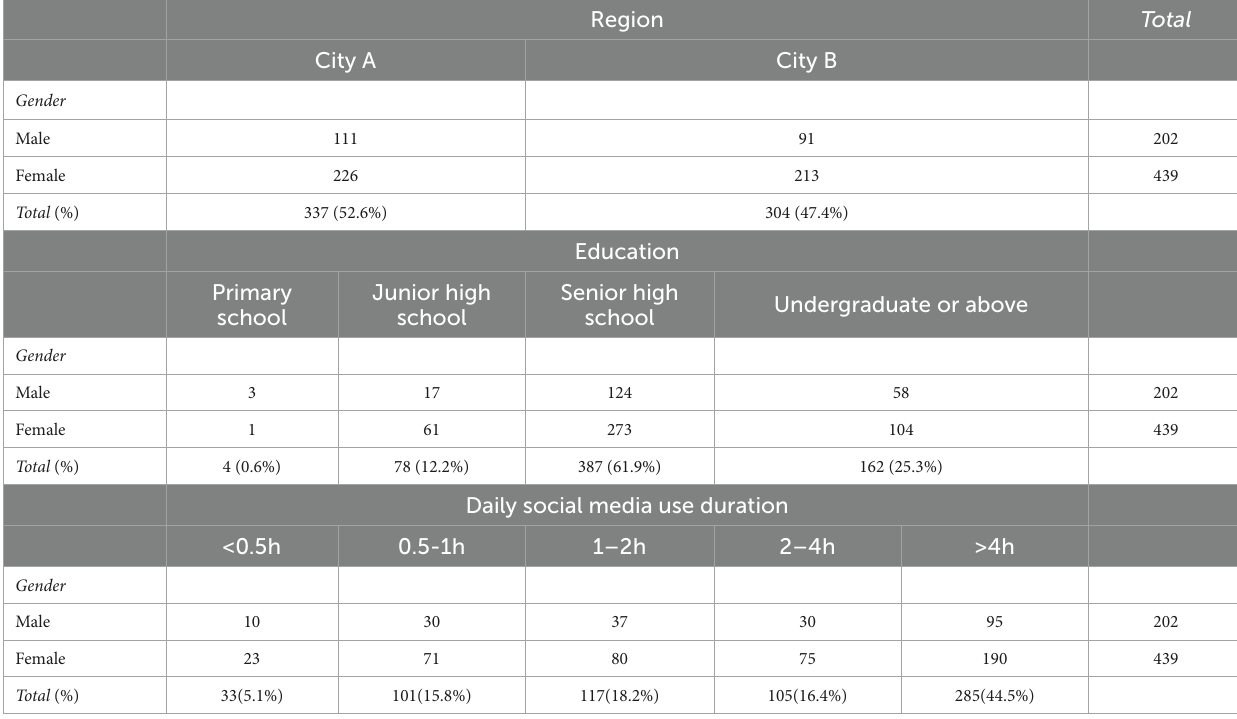
TABLE 1 Demographic information of participants ( N = 641).